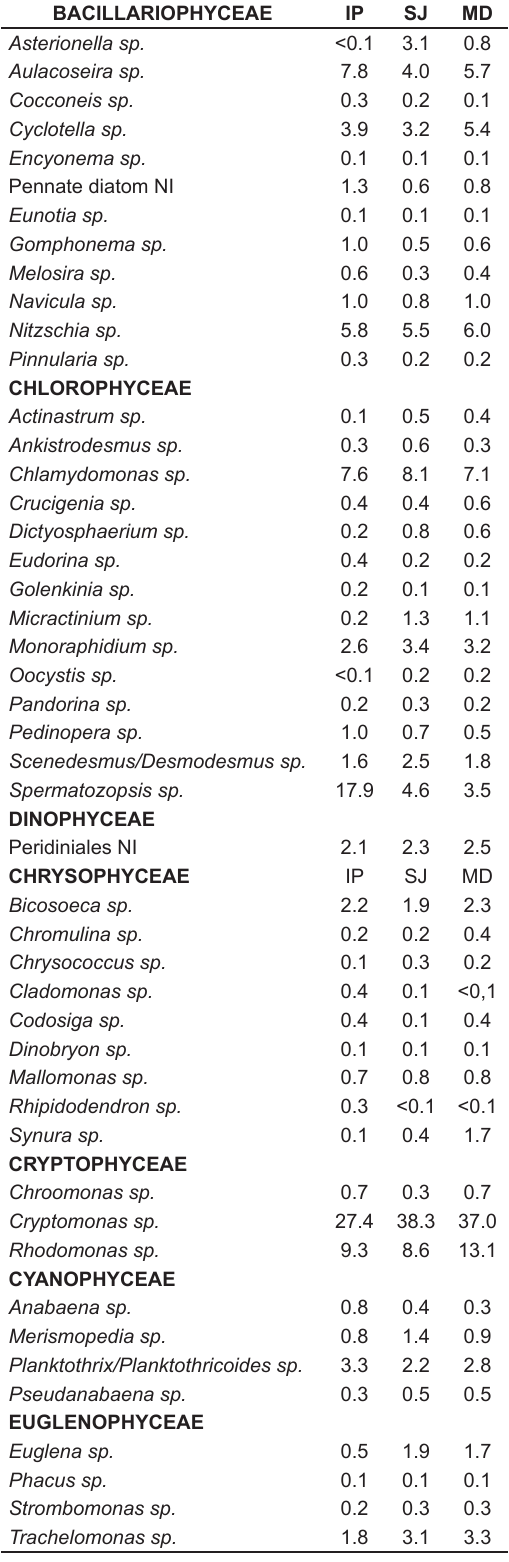
Table 2. Average relative contribution (%) of descriptive taxa to the total density of phytoplankton at the IP, SJ and MD sites in Guaiba Lake; NI –